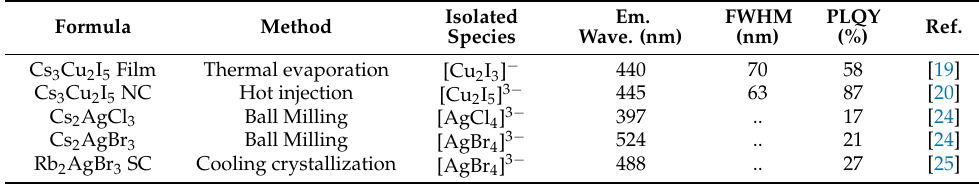
Table 1. Properties of 0D metal halide with monovalent